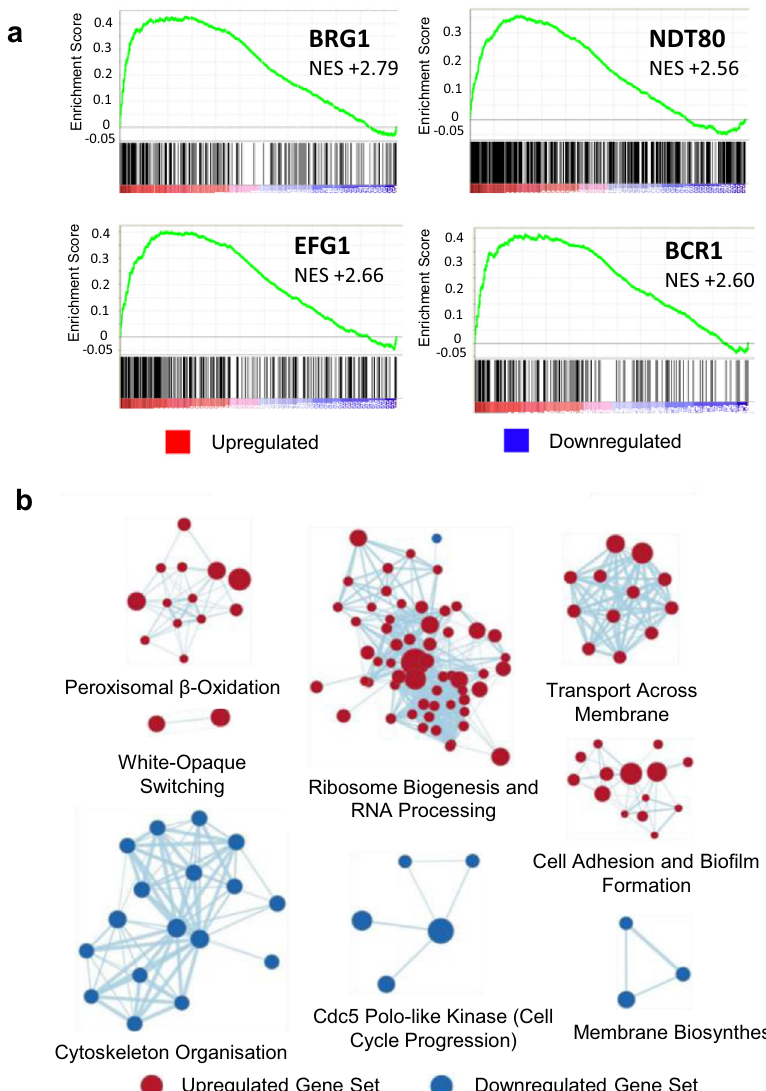
Fig. 6 Global gene expression changes in 5% CO 2 vs. 0.03% CO 2 C . albicans bio fi lms. a GSEA enrichment plots of central bio fi lm regulator gene sets with altered expression levels as assessed by RNA Sequencing; four of the nine identi fi ed core regulators of bio fi lm formation (Brg1, Efg1, Ndt80, and Bcr1) 20 were identi fi ed as having positive GSEA scores. Vertical black lines represent individual genes in the signi fi cantly differentially expressed ranked gene list from upregulated (left) to downregulated (right). The enrichment score increases if there are lots of genes towards the beginning of the ranked list (upregulated). NES normalised enrichment score; positive NES indicates enrichment in the upregulated group of genes. b Gene set cluster map showing the most upregulated and downregulated gene sets as determined by GSEA along with their cellular functions. Each circle is a gene set and the lines between them depict how much they overlap, thicker line = more genes in